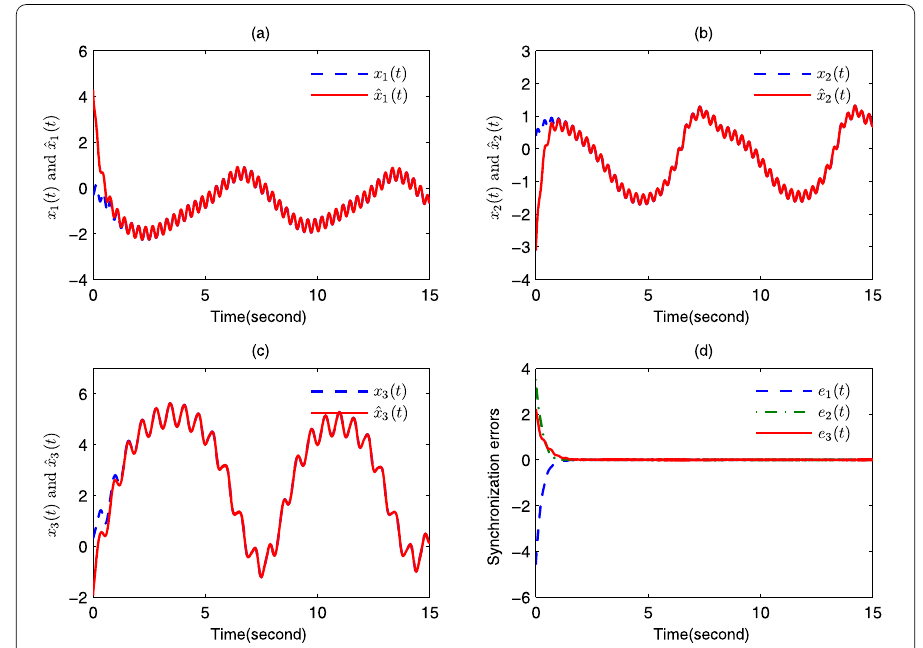
Figure 3 Simulation results when u ( t ) = [5sin(20 t ),3cos(20 t ),4sin(10 t )] T in ( a ) x 1 ( t ) and ˆ x 1 ( t ); ( b ) x 2 ( t ) and ˆ x